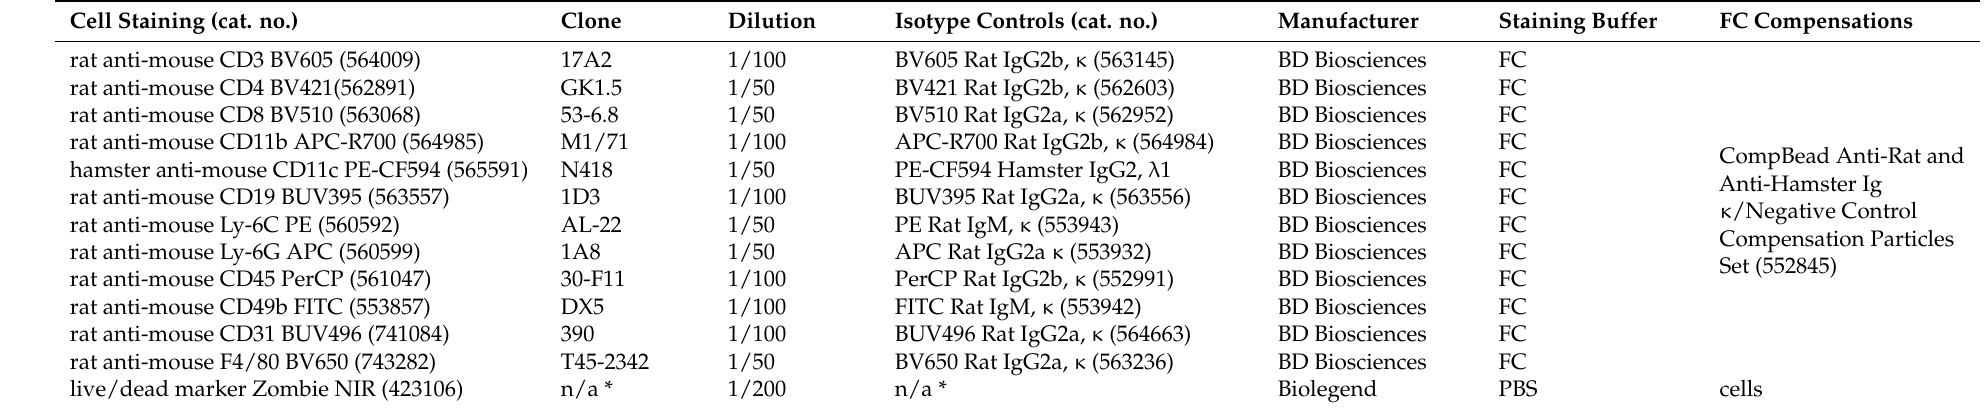
Table 1. Materials for